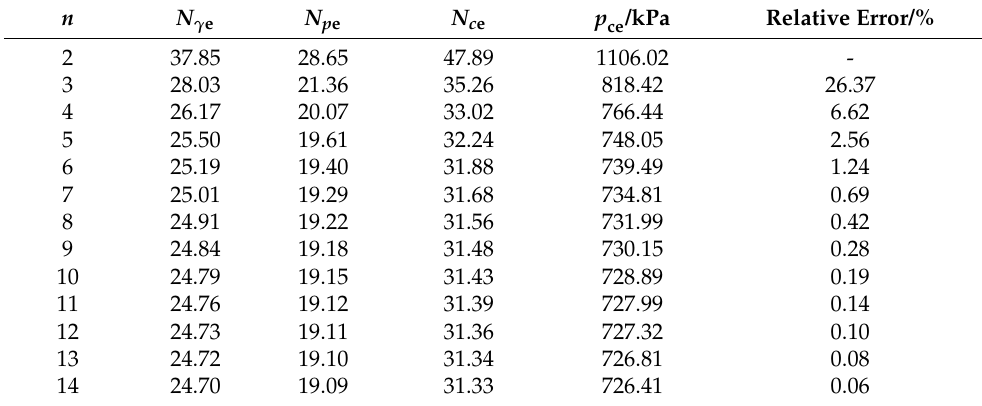
Table 1. Values of bearing capacity factors versus the number of blocks.